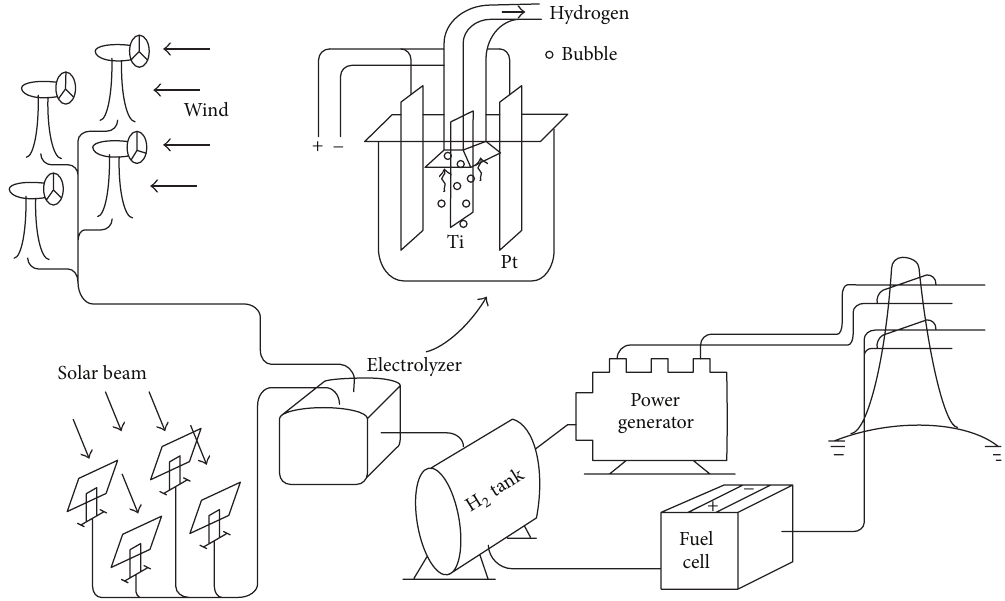
Figure 1: Schematic diagram showing hydrogen gas produced and stored from renewable power.